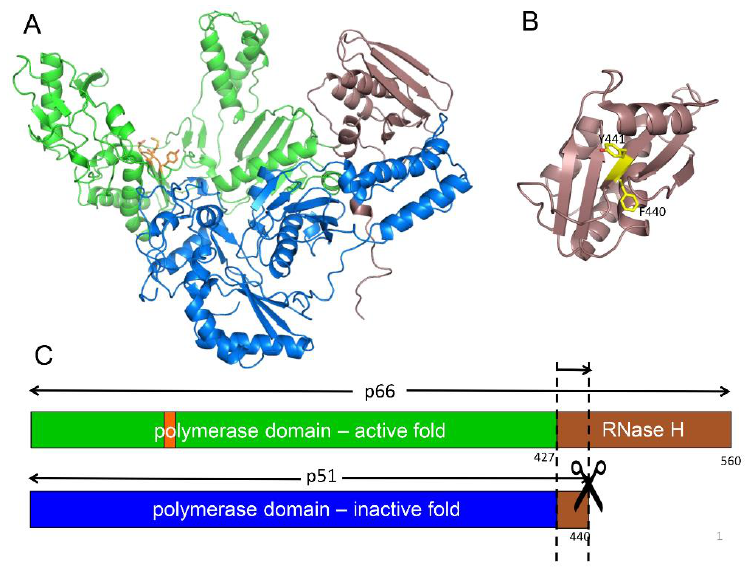
Figure 1. Structure of the reverse transcriptase (RT) heterodimer. ( A ) Ribbon diagram of p66/p51 showing the active polymerase (green) and ribonuclease H (RNase H, brown) domains in p66, and the inactive polymerase (blue) and RNase H domain fragment, residues 427–440 (brown), in the p51 subunit. The YMDD motif at the active site in p66 is shown in orange; ( B ) Structure of the isolated RNase H domain identifying the buried Phe440–Tyr441 cleavage site (yellow); ( C ) Domain structure of the two RT subunits color coded as in A, and illustrating the internal cleavage site that produces the p51 subunit.